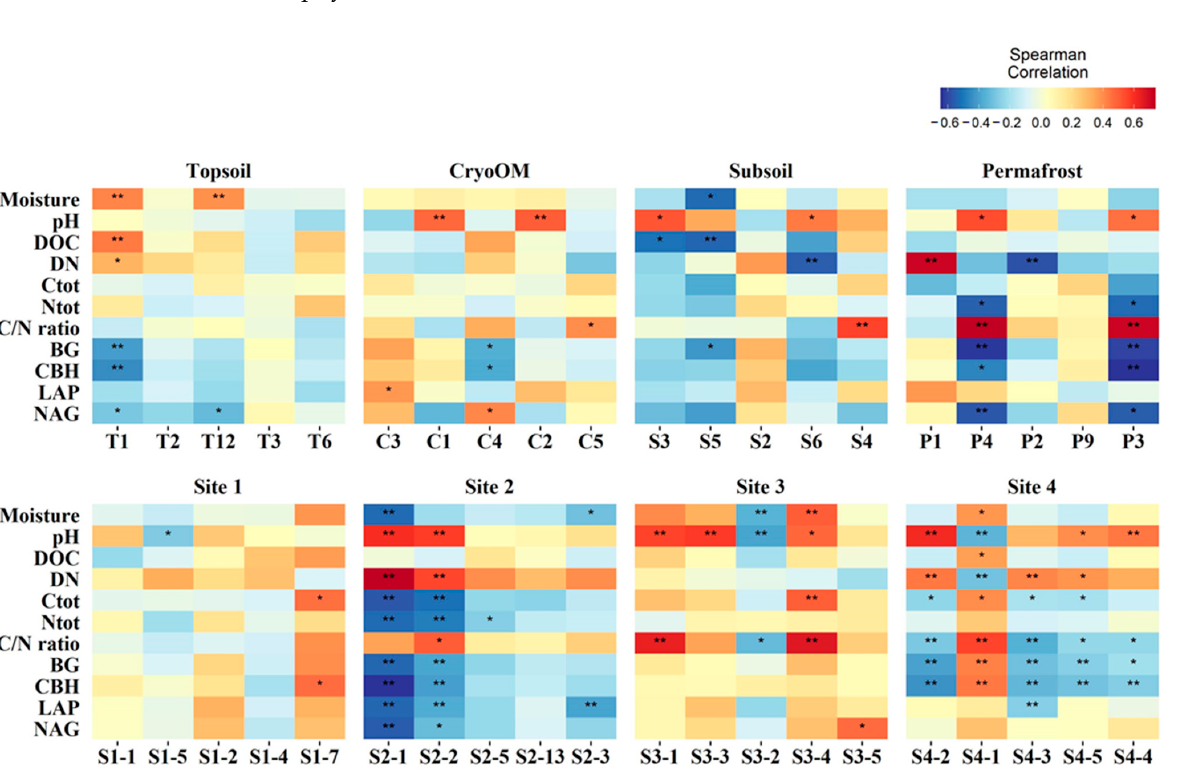
Figure 4. Spearman rank correlation coefficients of soil environmental factors and network modules (top five) for individual horizons and tundra sites. The reds represented a positive correlation and the blue represented a negative correlation. The heatmap cells marked by “*” or “**” were statistically significant: * p -value < 0.05 and ** p -value < 0.01.